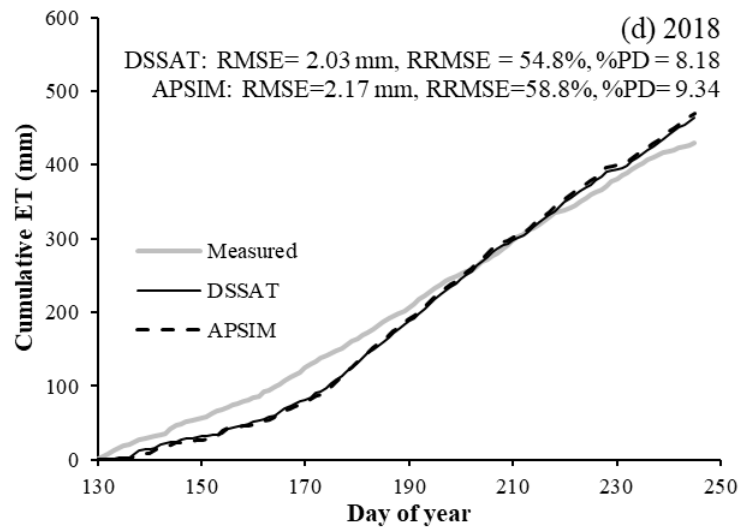
Figure 2. Comparisons of daily and cumulative seasonal ET-measured with eddy covariance (EC)-simulated by DSSAT and APSIM for calibration ( a , b ) during 2017 and validation ( c , d ) during 2018 growing seasons .